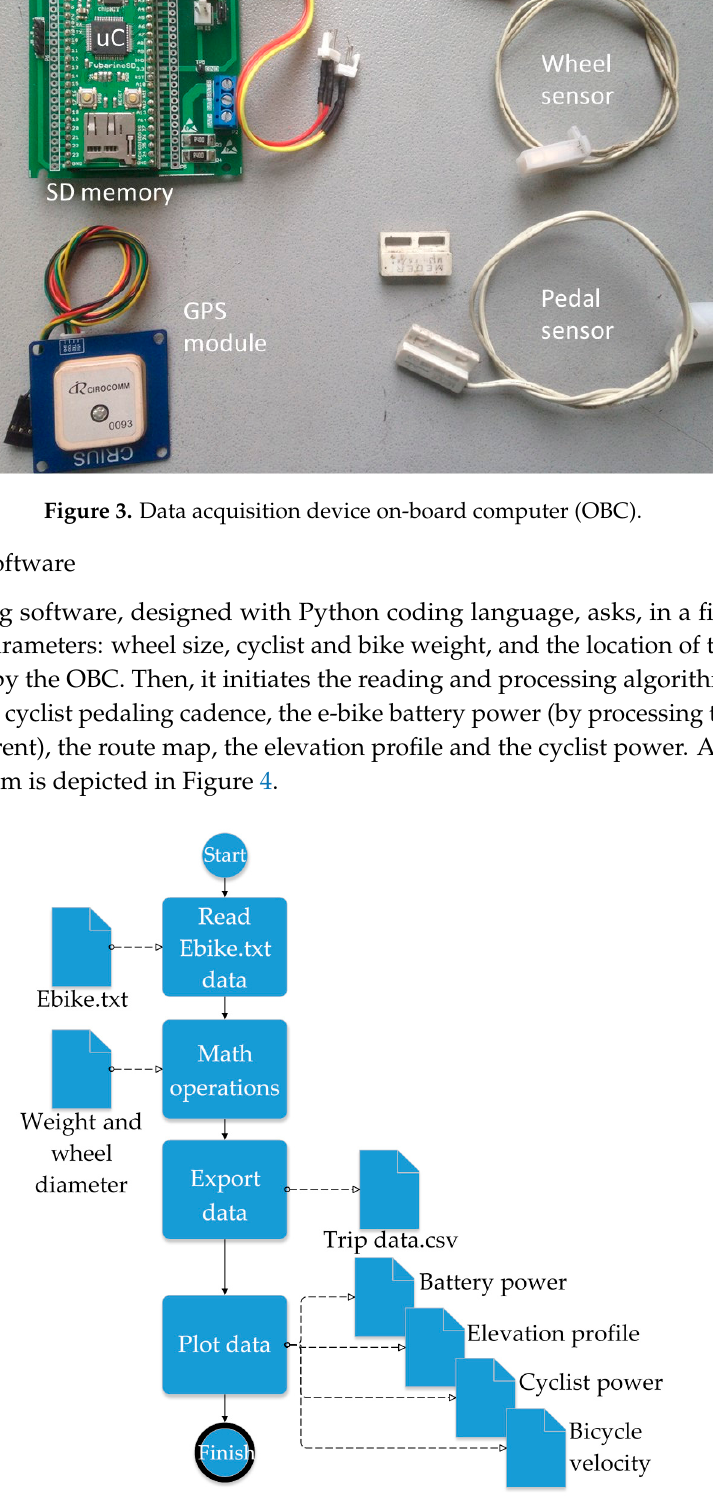
Figure 4. Developed software flowchart.